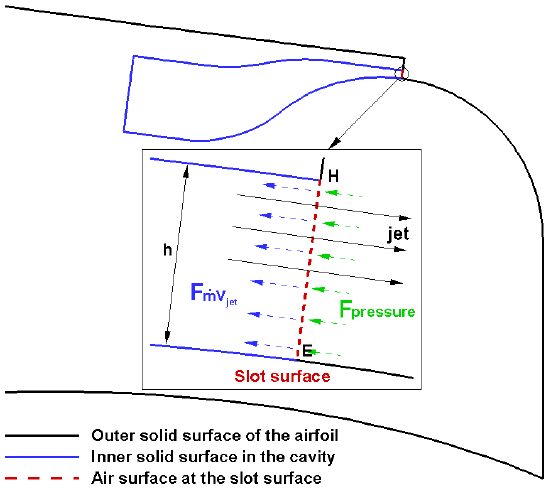
Figure 3. Close-up of the trailing edge area of the DU97-Flatback-PCC airfoil.